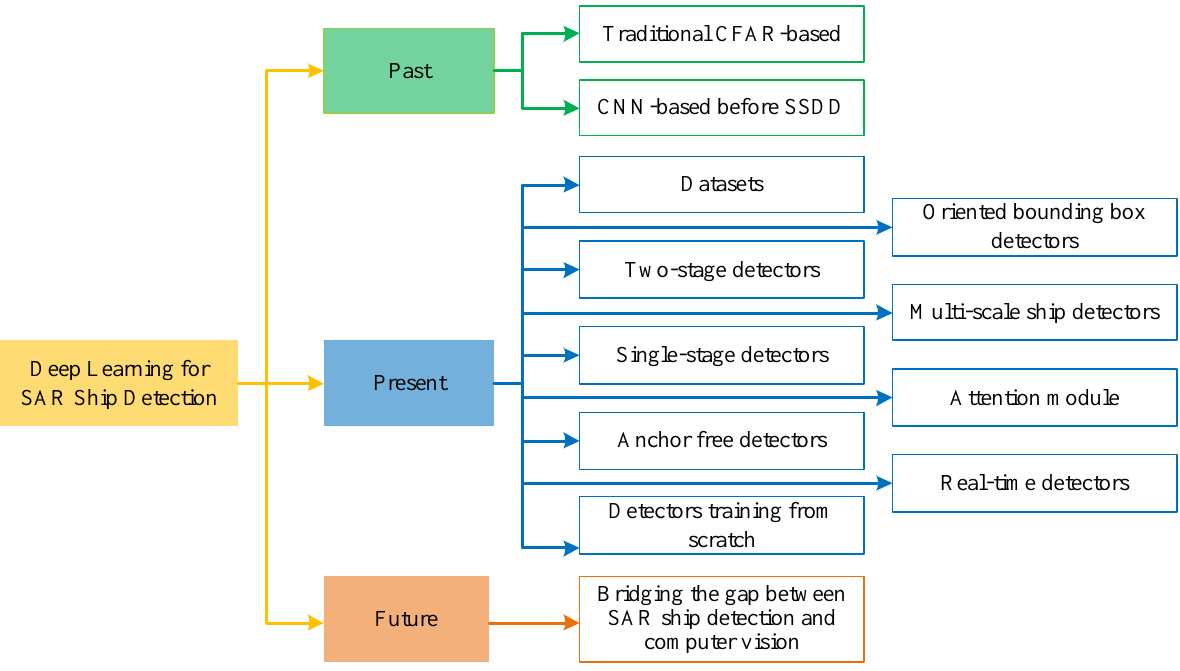
Figure 1. The overall architecture of the paper.